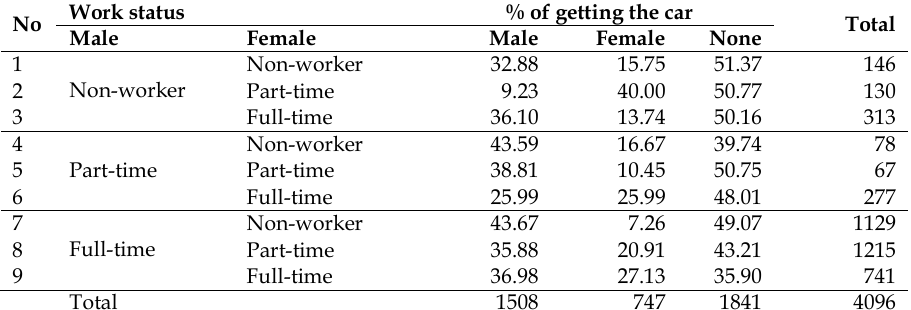
Table 7. Frequency Distribution of Work Status across the Action